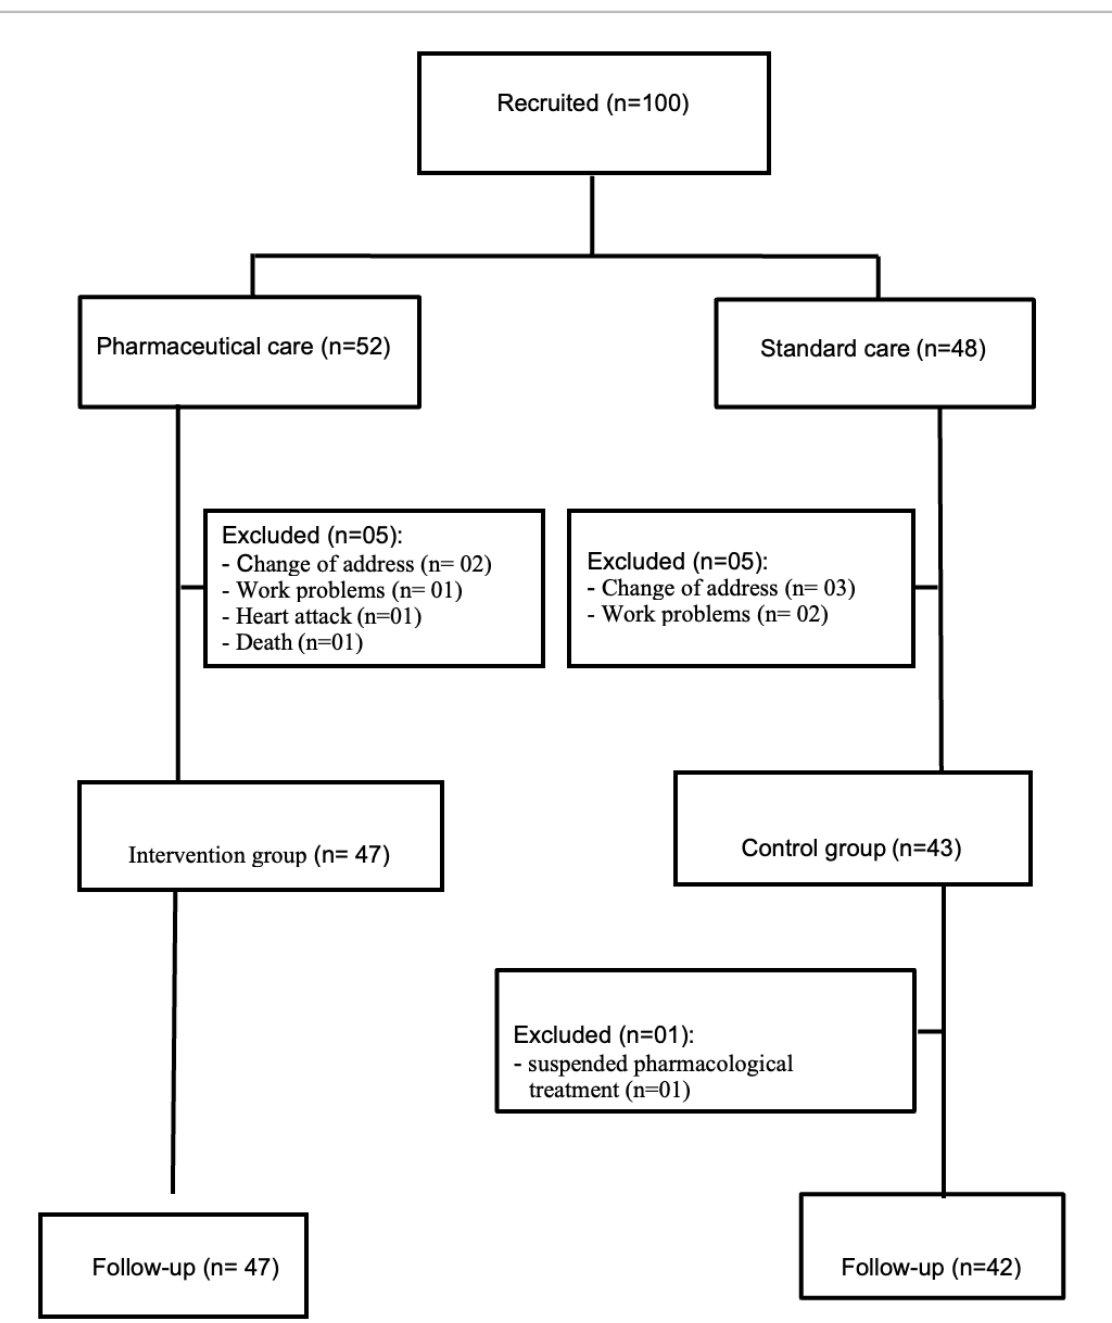
FIGURE 1 - The CONSORT diagram with the allocation and follow-up od patients, Paraíba - Brasil